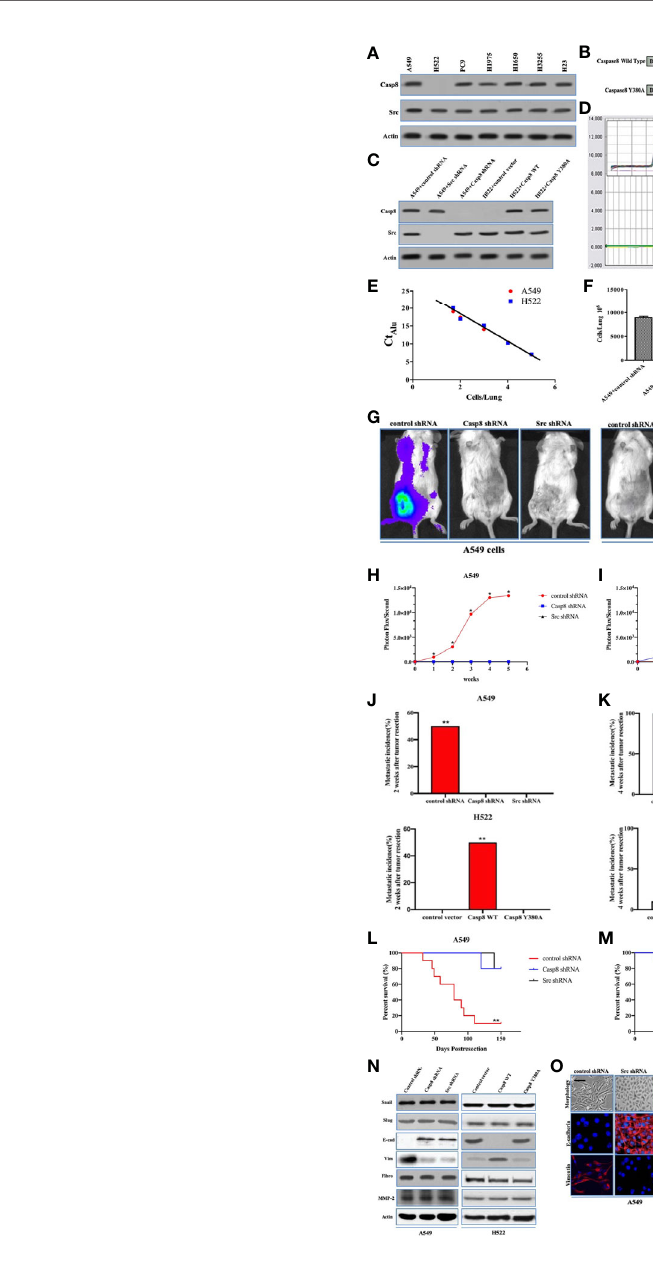
FIGURE 1 | Tyrosine 380 of Caspase-8 was pivotal for lung adenocarcinoma metastasis through EMT. (A) Immunoblotting analysis of Caspase-8, c-Src and b -actin in various human lung adenocarcinoma cell lines, A549, NCI-H522, NCI-H1975, NCI-H1650, NCI-H3255, NCI-H23 and PC9. (B) Schematic representation of various mutants of Caspase-8 that were used in this study. (C) Immunoblotting analysis of Caspase-8, c-Src and b -actin in A549 + control/Src/Casp8 shRNA and H522 + control vector/Casp8 WT/Casp8 Y380A. (D) Alu PCR was used to amplify alu repeat sequences in human (A549 cells) DNA. Quantitative real-time alu PCR was performed on genomic DNA extracted from the indicated number of A549 cells serially diluted into individual chick embryo lung homogenates. (E) Real-time quantitative alu PCR was used to generate a standard curve from A549 cells/lung by plotting the Ct against the number of cells per lung. (F) A quantitative analysis of spontaneous metastasis in the chick embryo using different human tumor cells. vs . control, ** p < 0.01. (G – I) Ectopically grown A549/H522 tumors were surgically removed. Biweekly quanti fi cation of bioluminescence showed accelerated tumor growth and increased spontaneous metastasis in the mice implanted with A549 + control shRNA (H) and H522 + Casp8 WT (I) (* p < 0.05). Data were presented as mean ± SD. (J, K) Total cumulative incidences of metastasis con fi rmed by immunostaining in the tumor-implanted mice cohorts by 2 or 4 weeks after tumor removal (** p < 0.01). Metastatic events were con fi rmed by immunostaining in various organs of BALB/c nude mice. Tissue sections were scored as positive or negative based on the presence or absence of detectable metastasis. (L, M) Kaplan-Meier survival curves for each group of mice with A549 cells (L) and H522 cells (M) . (N) Immunoblotting analysis of Snail, Slug, E-cadherin (E-cad), Vimentin (Vim), Fibronectin (Fibro), MMP-2 and b -actin in A549 + control/Src/Casp8 shRNA and H522 + control vector/Casp8 WT/Casp8 Y380A. (O) Immuno fl uorescence of E-cadherin and Vimentin. Decreased E-cadherin and increased Vimentin in the Casp8 + Src + cells with spindle and dendritic shapes (scale bars = 50 m